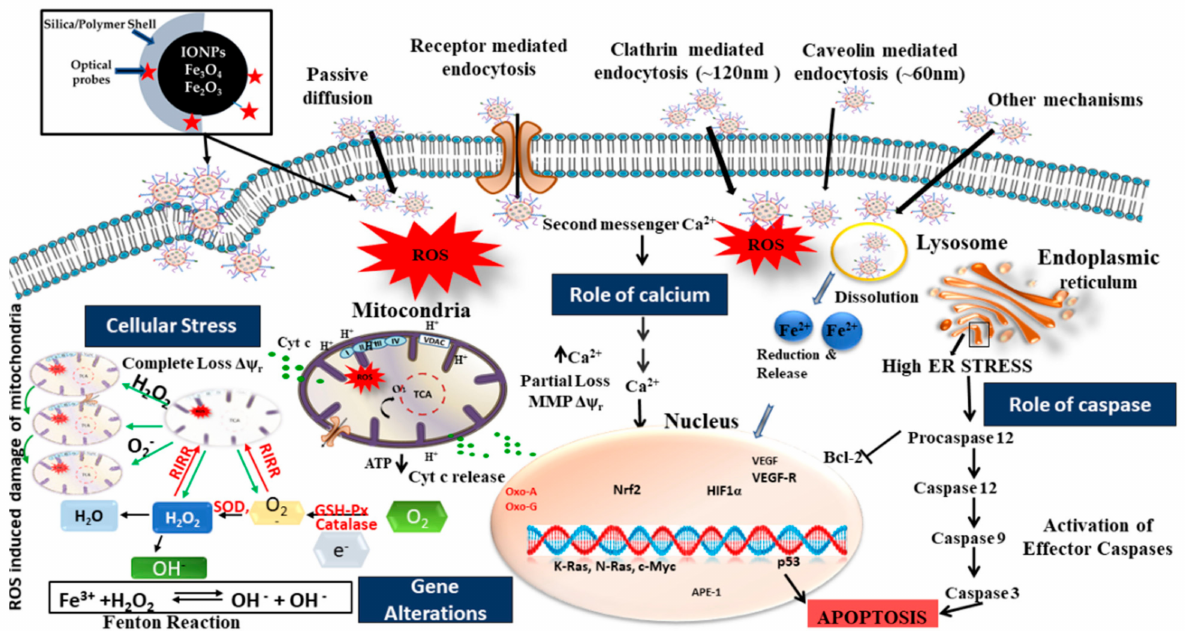
Figure 8. Possible mechanisms of iron oxide-based nanocomposites induced toxicity at the cellular